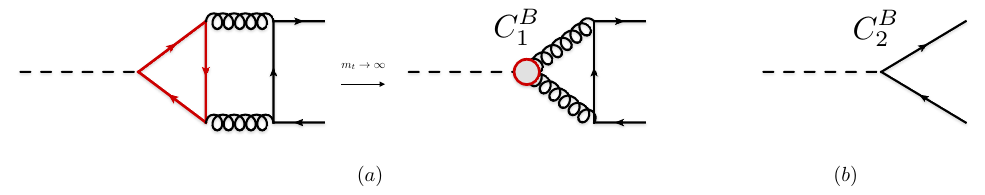
Figure 2. The generation of C 1 and C 2 , ( a ) illustrates the generation of the Hgg operator (with subsequent coupling to bottom quarks relevant for this paper). Shown is the SM (left) in which the top quark (red) circulates in the loop, after integrating out the top quark the diagram on the right is generated with a coupling proportional to C 1 . On the rightmost side ( b ) illustrates the C 2 coupling, which at lowest order matches the SM coupling between a Higgs boson and bottom